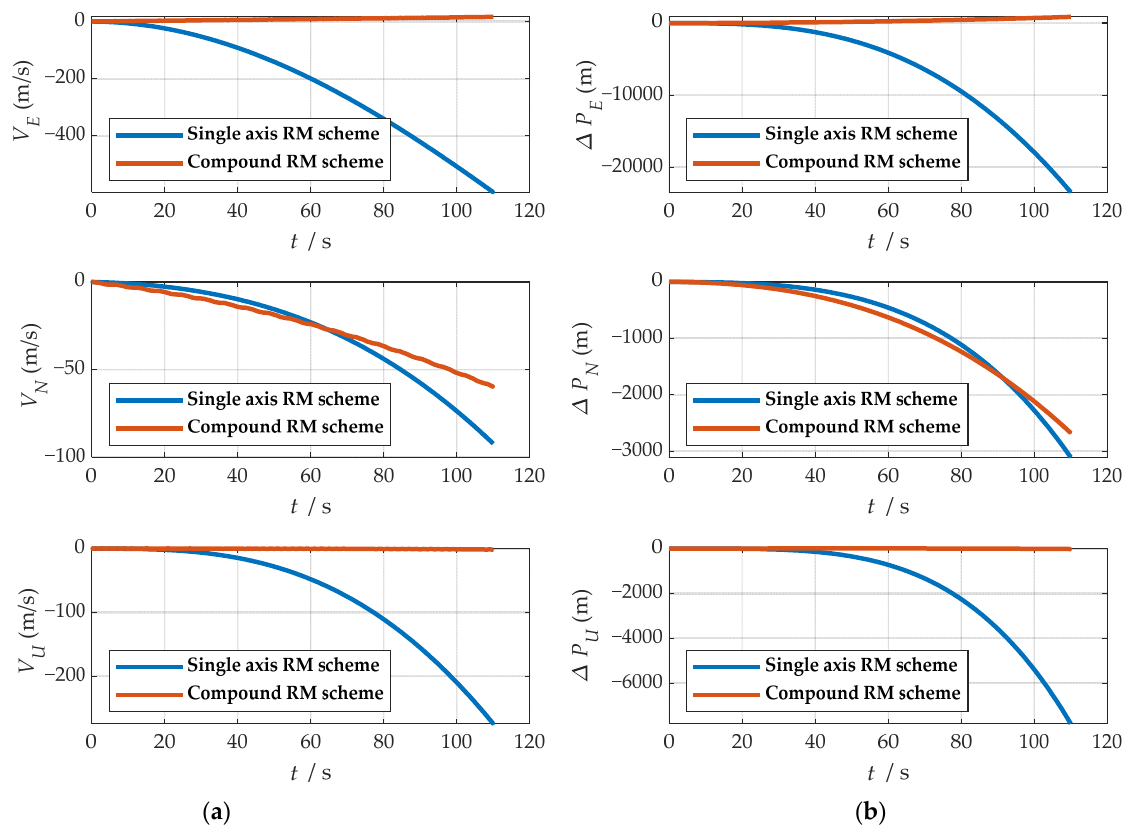
Figure 23. Comparison of attitude solution results: ( a ) comparison of calculation results of yaw angle; ( b ) comparison of calculation results of roll angle; ( c ) comparison of calculation results of pitch angle.